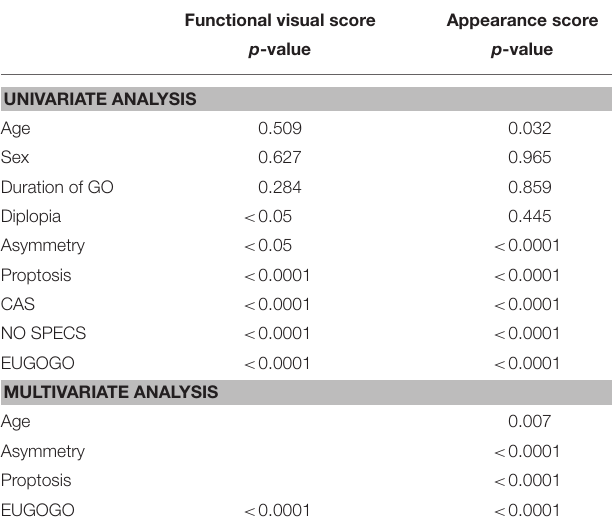
TABLE 3 | Associations between QOL score and clinical variables, CAS, NOSPECS, and EUGOGO domains by using univariate and multivariate regression stepwise analysis.